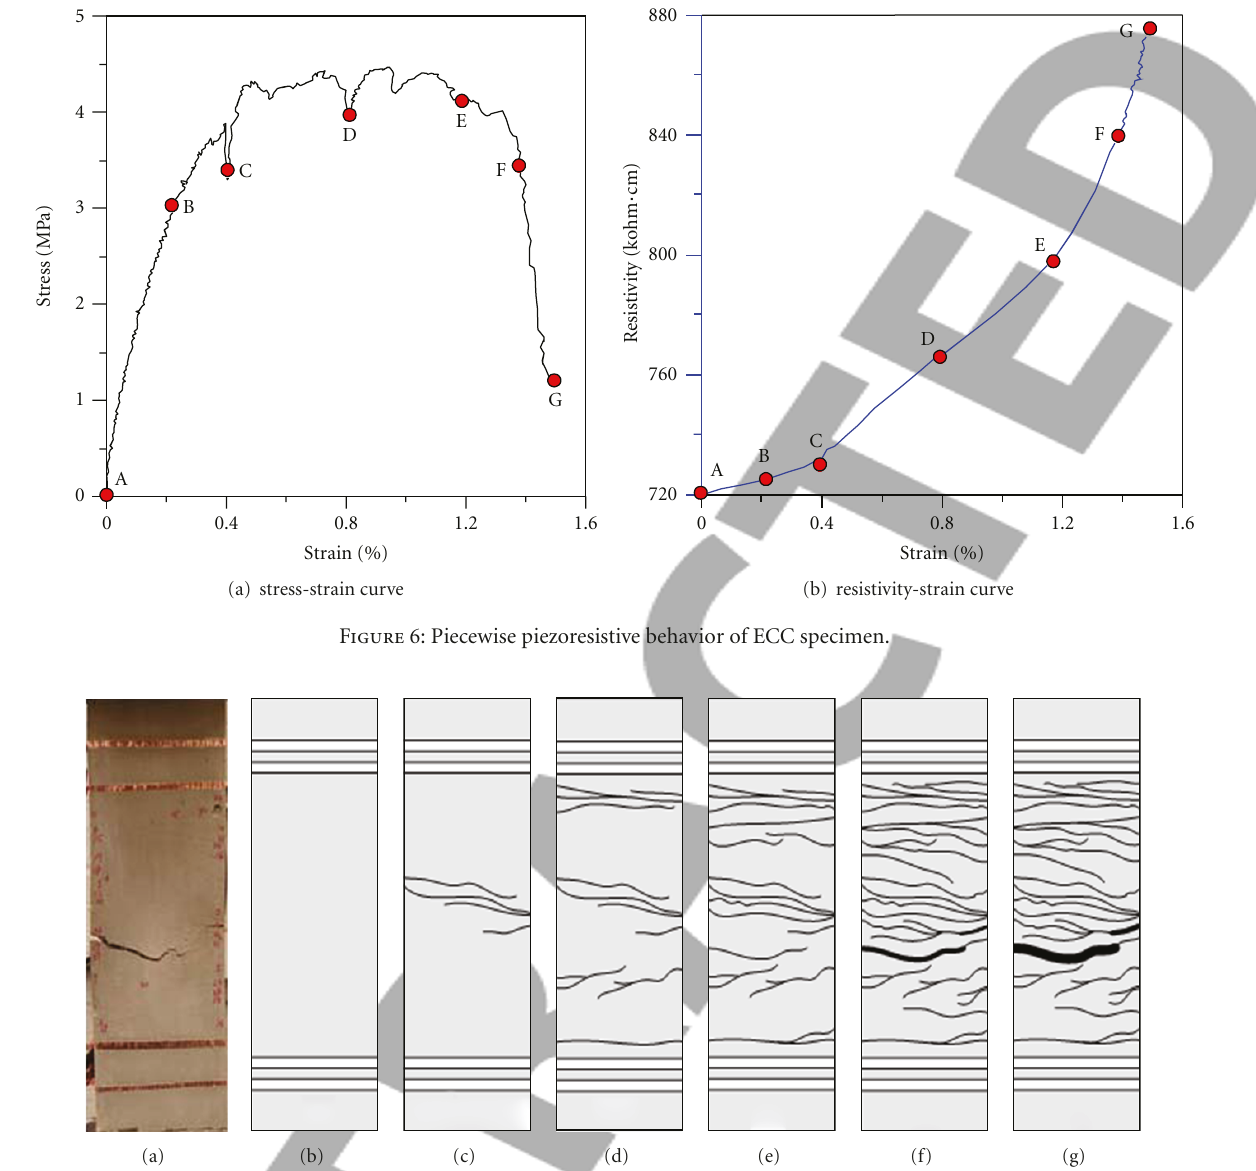
Figure 7: (a) Photo of the specimen after crack localization (at point G); (b)–(g), Cracking patterns at loading point B through G,